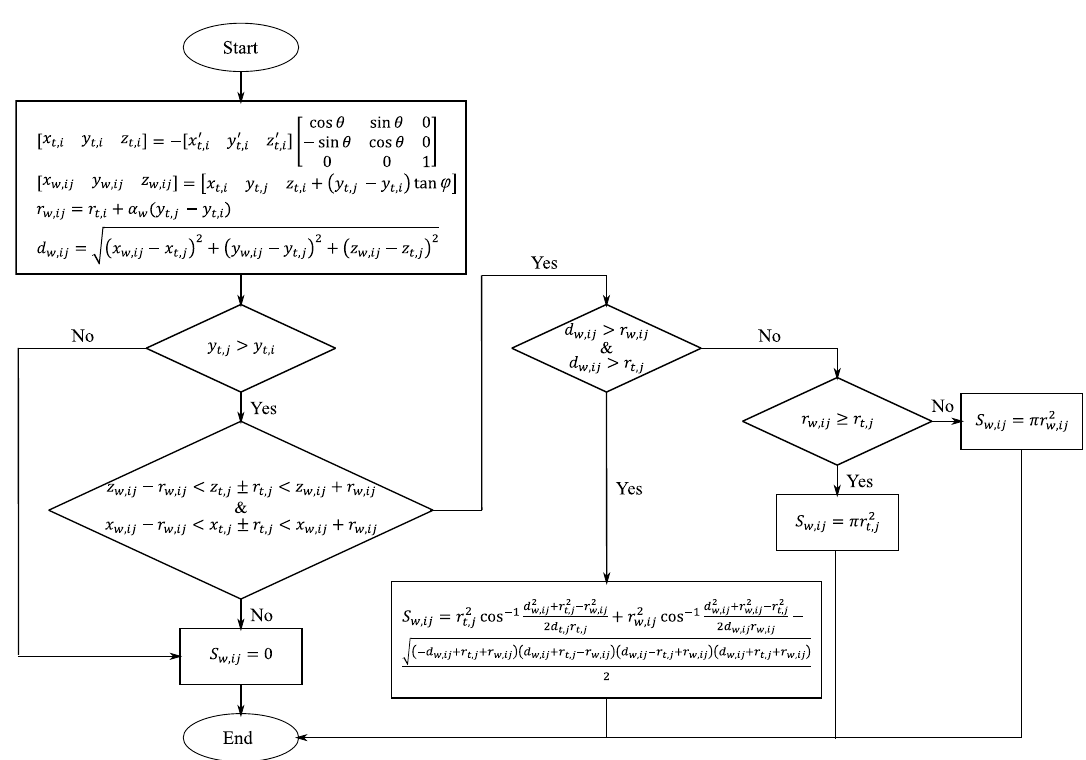
Figure 8. Flowchart describing the processing for calculating the affected swept area of wind turbine j .